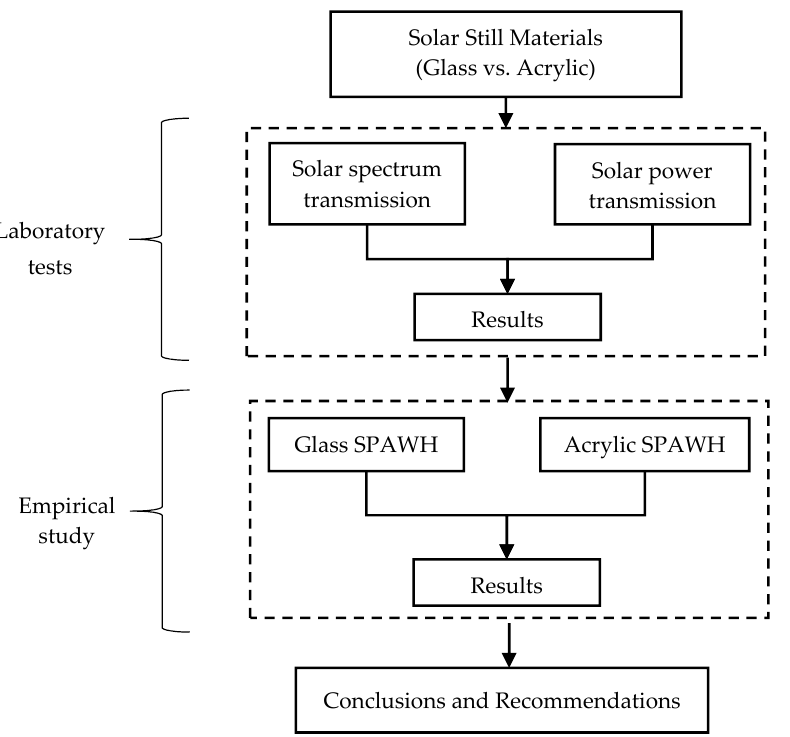
Figure 2. Research process flow.